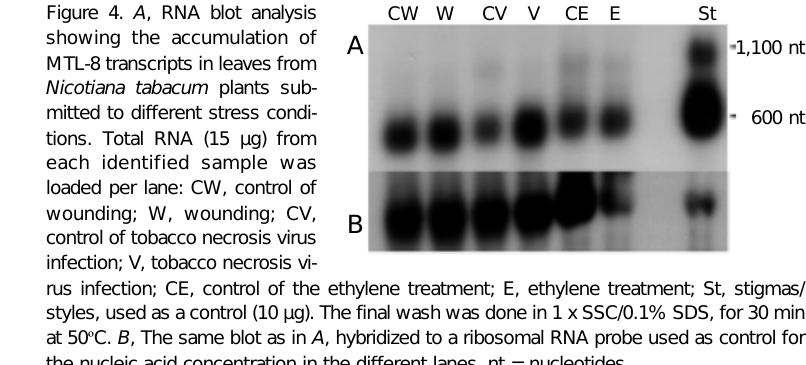
Figure 5. Genomic DNA of Nico- tiana tabacum digested with re- striction enzymes, separated by electrophoresis, transferred to Hybond N + filters and hybridized to the MTL-8 cDNA clone as a probe. The final wash was 0.1 x SSC/0.1% SDS, 30 min, at 65 º